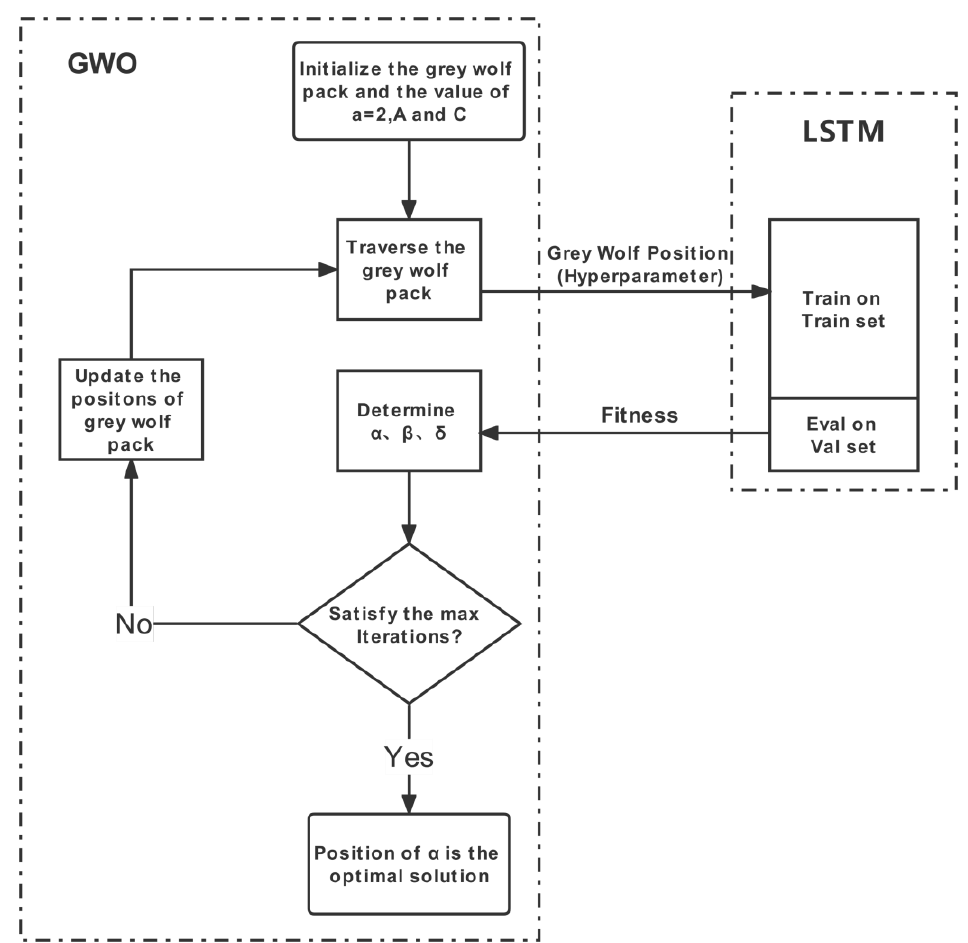
Figure 4. Hyperparameters optimization process by GWO with LSTM. “Readapted with permission from Ref. [41]. 2022, Pan et al.”